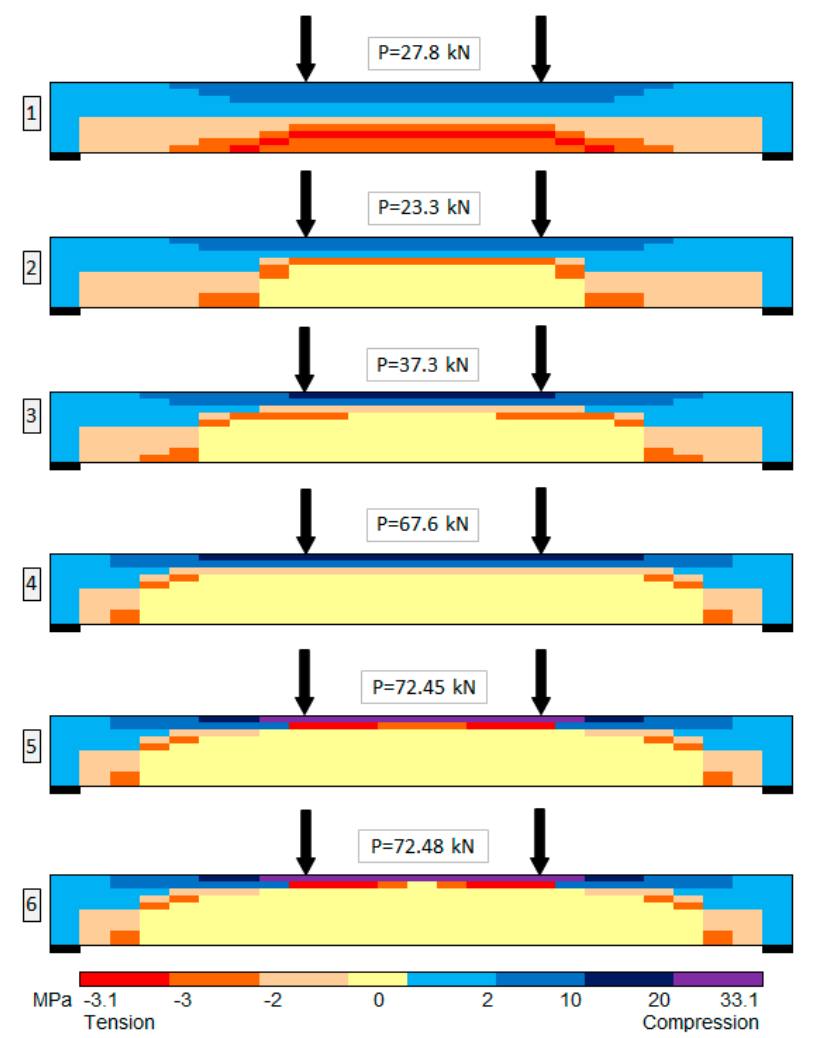
Figure 10. Distribution of normal stresses depending on the load of C1 beam.